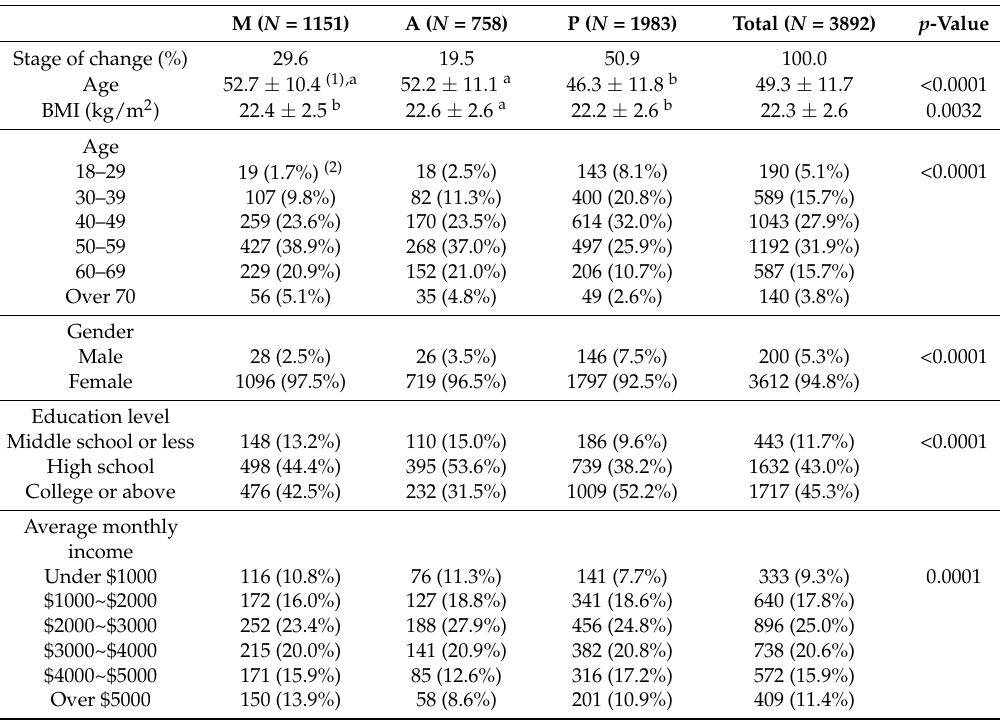
Table 1. Participants’